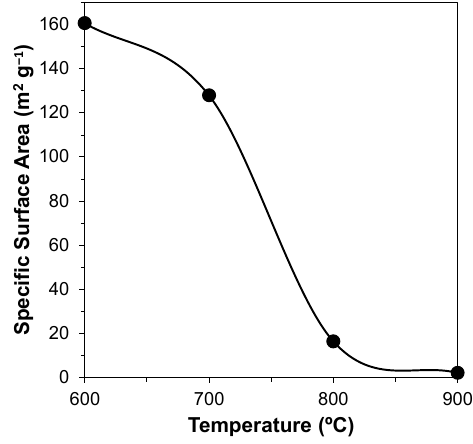
Figure 3. Effect of temperature on the specific surface area of the powders. It can be seen that the SSA after calcination at 600 ◦ C is still relatively high (~160 m 2 g − 1 ), and gradually decreases (to ~130 m 2 g − 1 ) with temperature increasing to 700 ◦ C. This is followed by a drastic change (to ~16 m 2 g − 1 ) with a further increase in the calcination temperature to 800 ◦ C, and then by a more gradual decrease to ~2–3 m 2 g − 1 upon heat treatment at 900 ◦